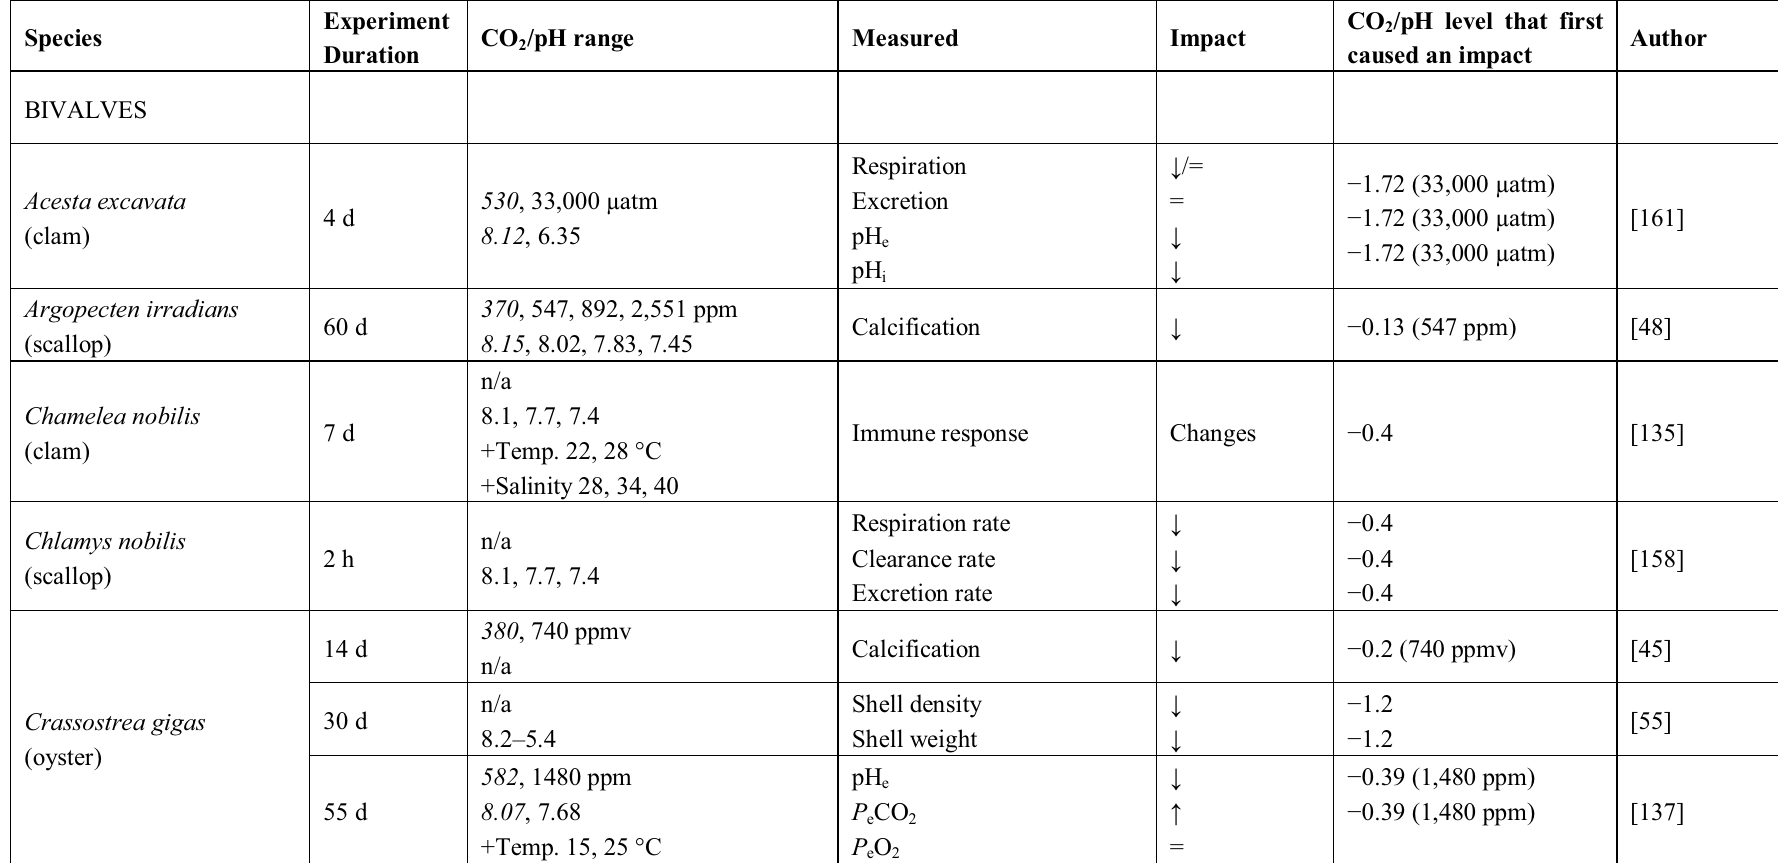
Table 1. Summary of the impacts of ocean acidification on juvenile and adult